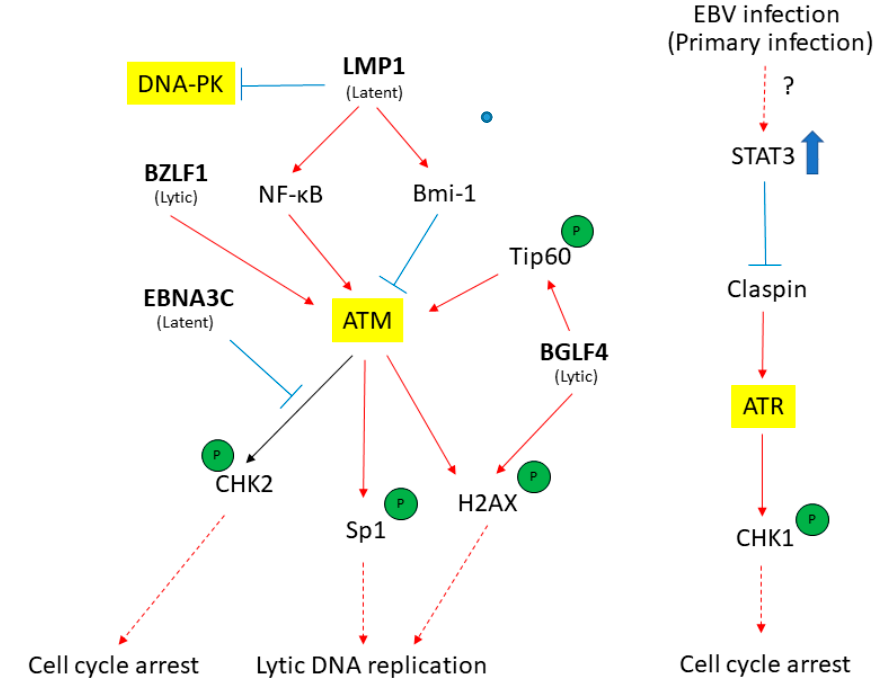
Figure 4. The EBV latent and lytic genes deregulates DDR transducers in EBV-infected cells. A simplified version of signaling pathways is shown here. Viral components (in bold) that activate (red) or suppress (blue) DDR transducers are shown. See texts for detail description. T-bar indicates inhibition effect. The red arrow indicates the activation of proteins. The blue rough arrow shows the increase in STAT3 activation.